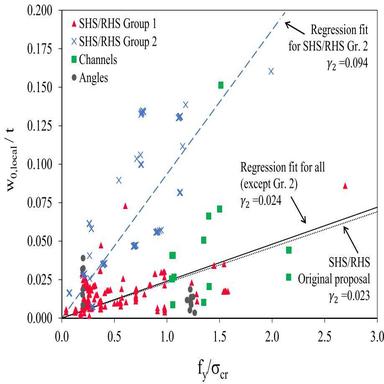
Assessment of predictive models for local imperfection amplitude in stainless steel cold-formed sections.